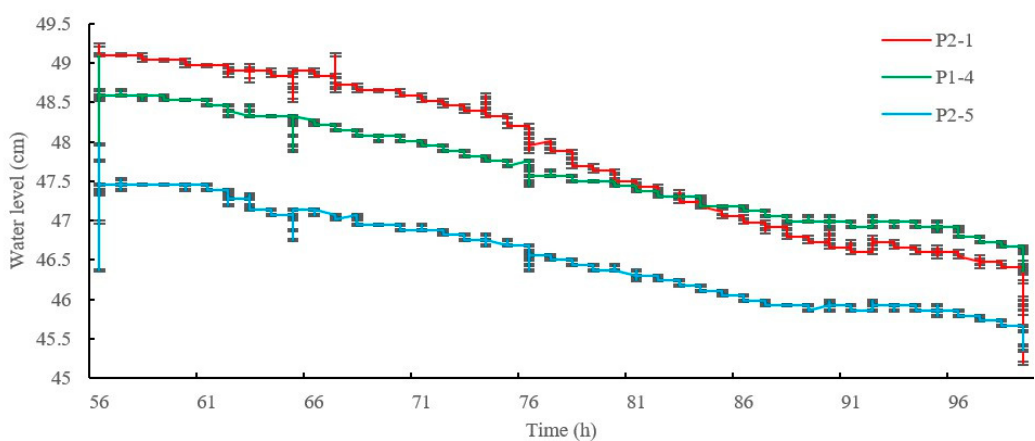
Figure 6. The evolution of water levels for typical pressure sensors (P2-1, P1-4, P2-5) over the stormwater infiltration period.